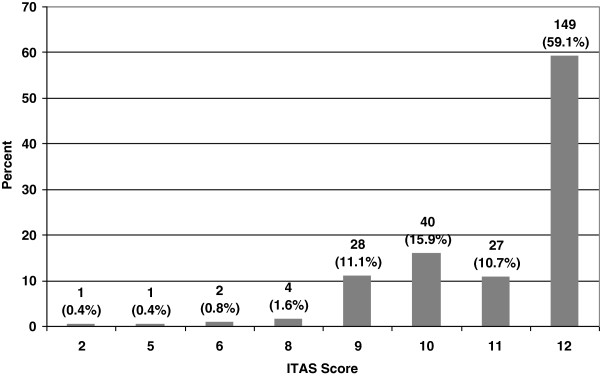
Distribution of scores on the Immunosuppressive Therapy Adherence Scale (ITAS).